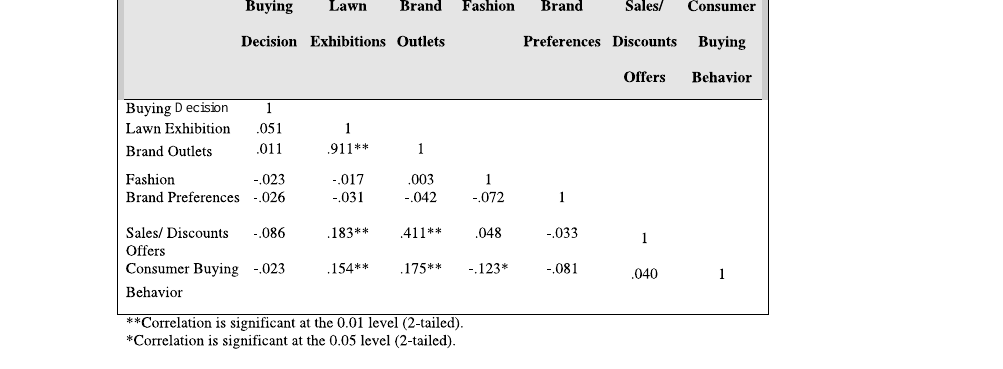
Table 2: Correlation Analysis